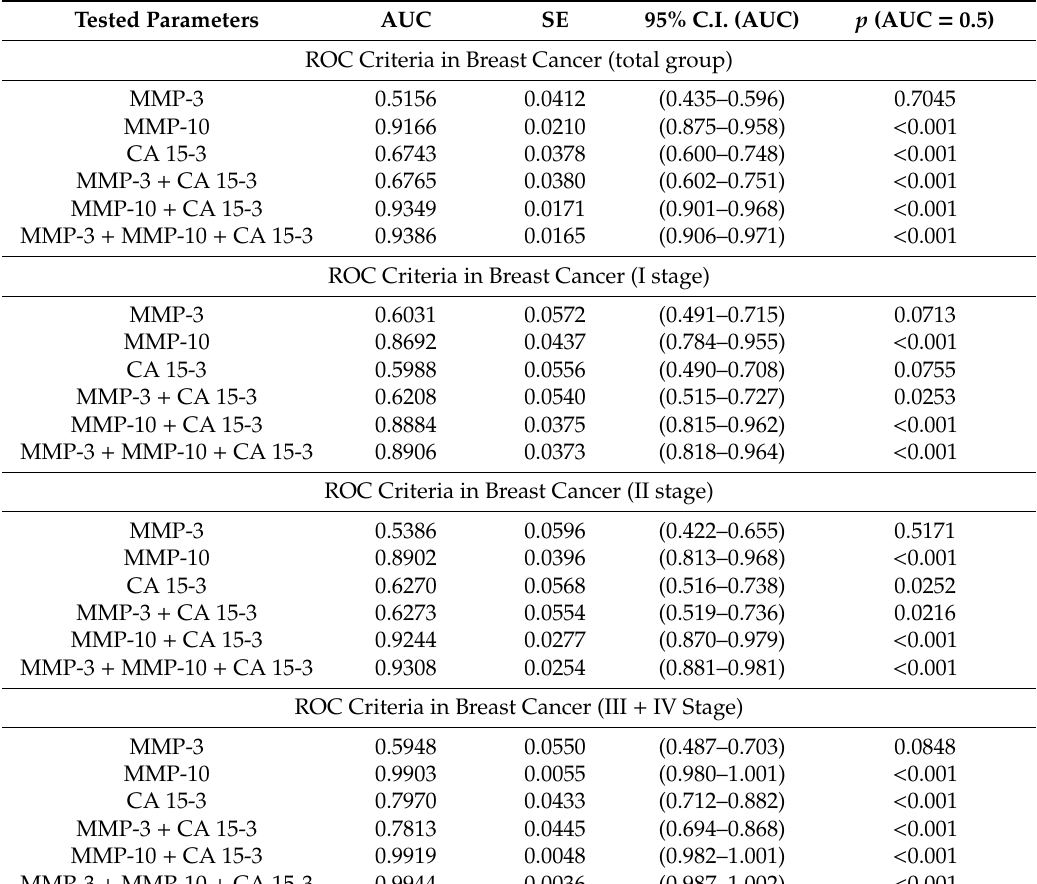
Table 4. Diagnostic criteria of the receiver operating characteristic (ROC) curve for tested parameters in